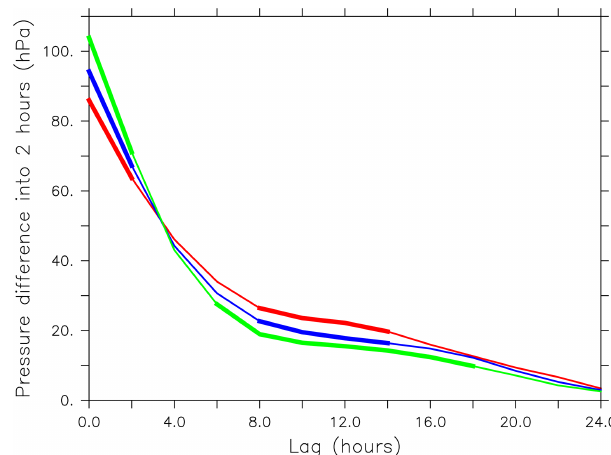
Figure 4. Time lag composite of the pressure difference in 2h over WCB trajectories for B85 (red), PCMT (blue) and NoConv (green) simulations. The zero lag corresponds to the time of maximum pres- sure difference. Only WCB trajectories having their maximum pres- sure difference reached before 12:00UTC on 2 October are consid- ered to get the same number of trajectories at all time lags. Thick segments correspond to time lags for which each composite is sig- nificantly different from the other two composites at 99.9% follow- ing a Welch